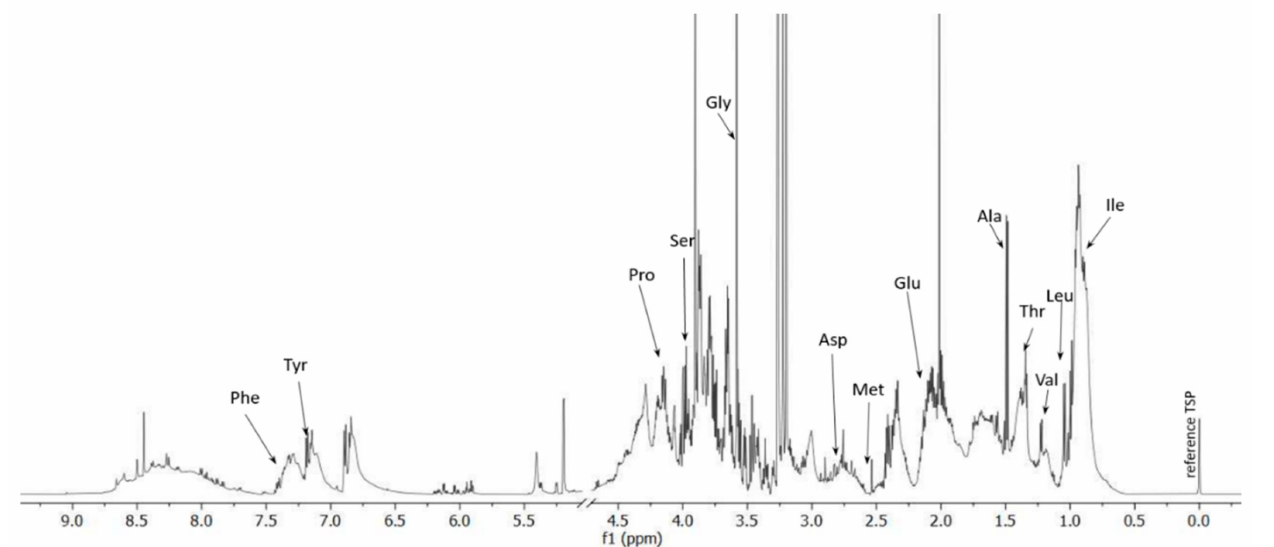
Figure 1. 1D 1 H NMR spectrum of the larvae